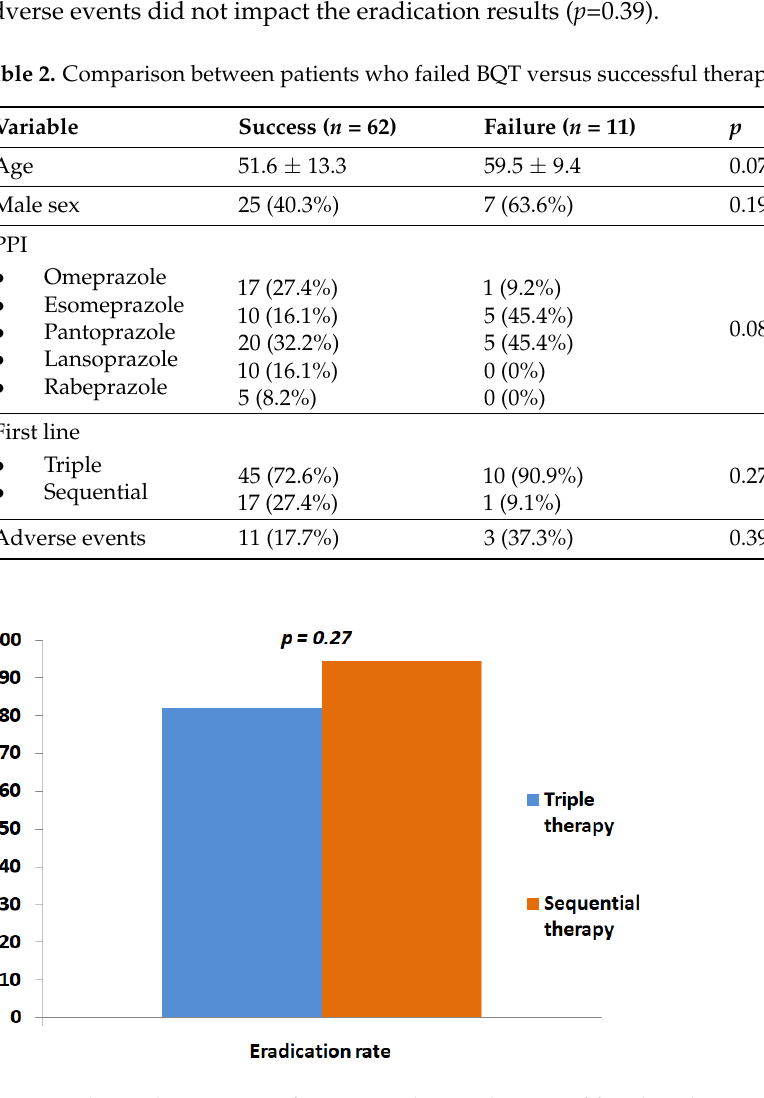
Figure 1. The eradication rate of BQT according to the type of first-line therapy used. Adverse events were observed in 14 subjects (20.5%). The most common ones were diarrhea (six patients) and weakness (six patients). Nausea (two patients), dysgeusia (two patients), and headache (two patients) were recorded less frequently. Five patients experienced more than one